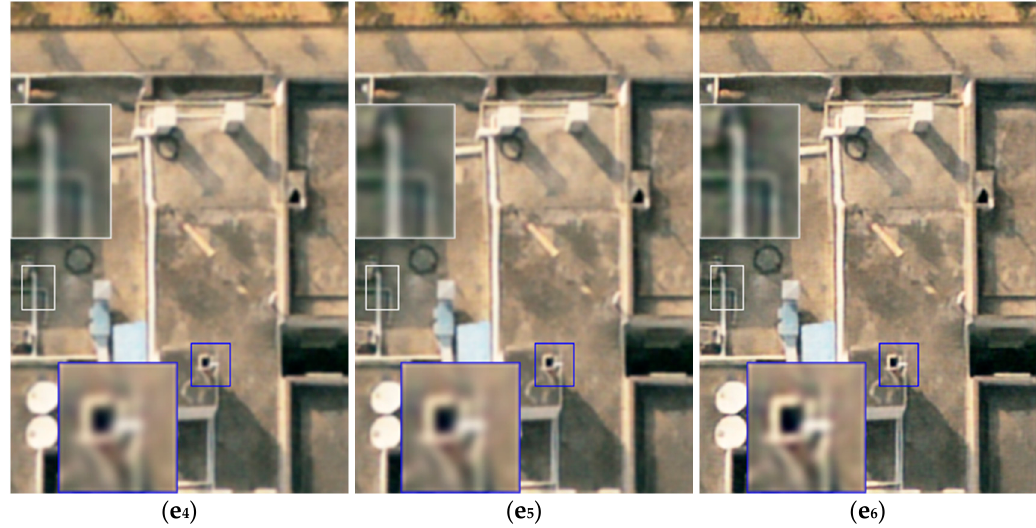
Figure 2. Testing results of several denoising methods for UAV images with several ground objects. In each group of images, the 1st image ( a 1 , b 1 , c 1 , d 1 , e 1 ) is the ground truth; the 2nd image ( a 2 , b 2 , c 2 , d 2 , e 2 ) is a noise image with noise level 35; and the 3rd image ( a 3 , b 3 , c 3 , d 3 , e 3 ) presents the denoising results of method [8]. The 4th image ( a 4 , b 4 , c 4 , d 4 , e 4 ) presents the denoising results of method [5]; the 5th image ( a 5 , b 5 , c 5 , d 5 , e 5 ) presents the denoising results of method [17]; and the 6th image ( a 6 , b 6 , c 6 , d 6 , e 6 ) presents the denoising results of the proposed method.